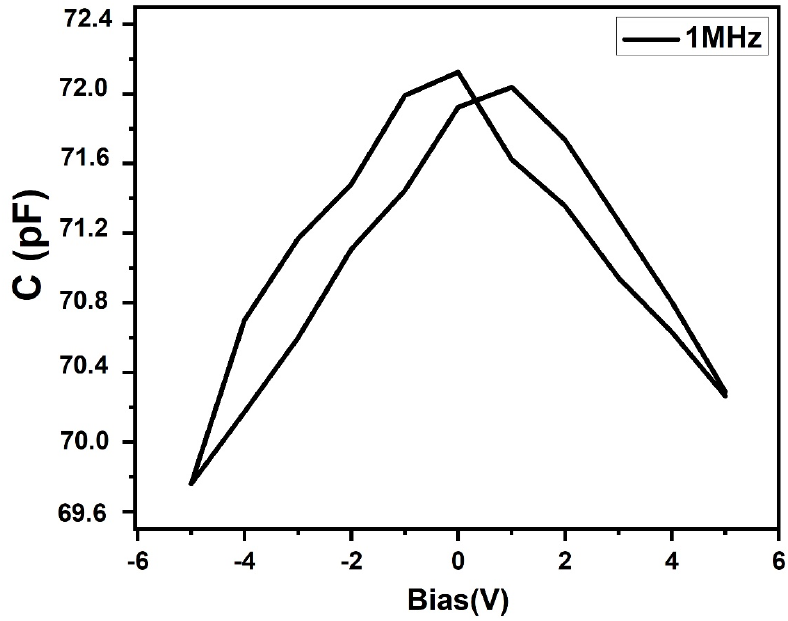
Figure 11. Capacitance–Voltage plot of as-deposited PbS at 1 MHz.